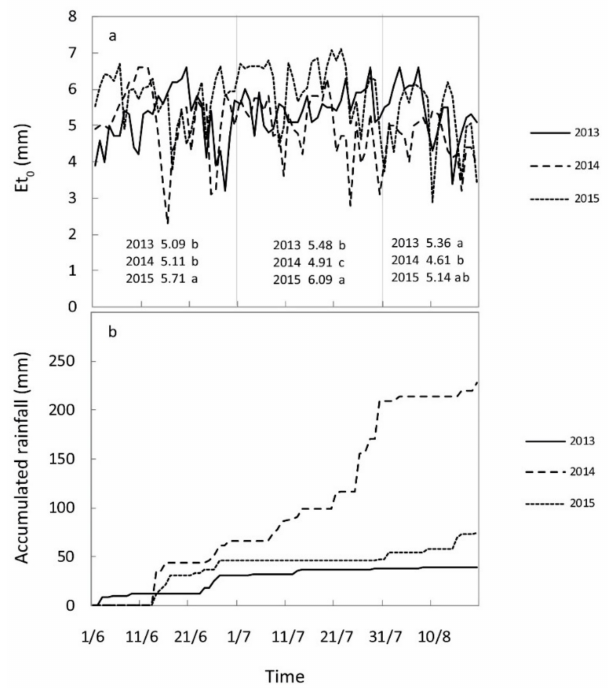
Figure 1. Seasonal patterns of reference evapotranspiration, with average monthly values, followed by letters representing significant differences at p < 0.05 ( a ), and accumulated rainfall over the period 1 June–20 August for the 2013, 2014, and 2015 seasons ( b